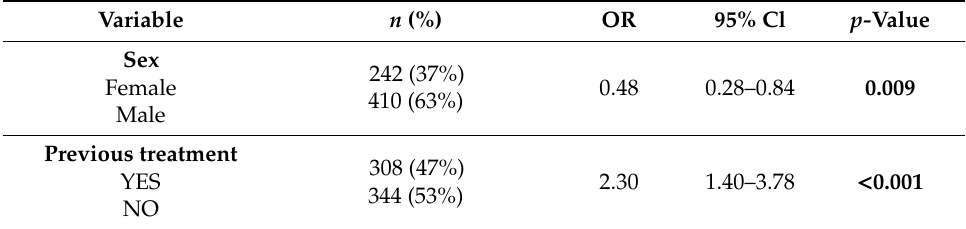
Table 5. Results of multivariate analyses for advanced † liver